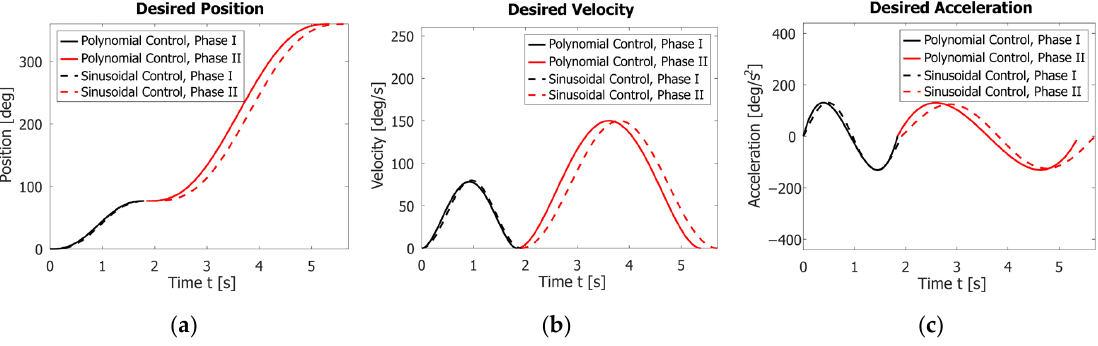
Figure 6. Comparison of the assignment angle positions ϕ for the two control laws ( a ). Comparison of the assigned angle velocities ( b ). Comparison of the assigned angle accelerations .